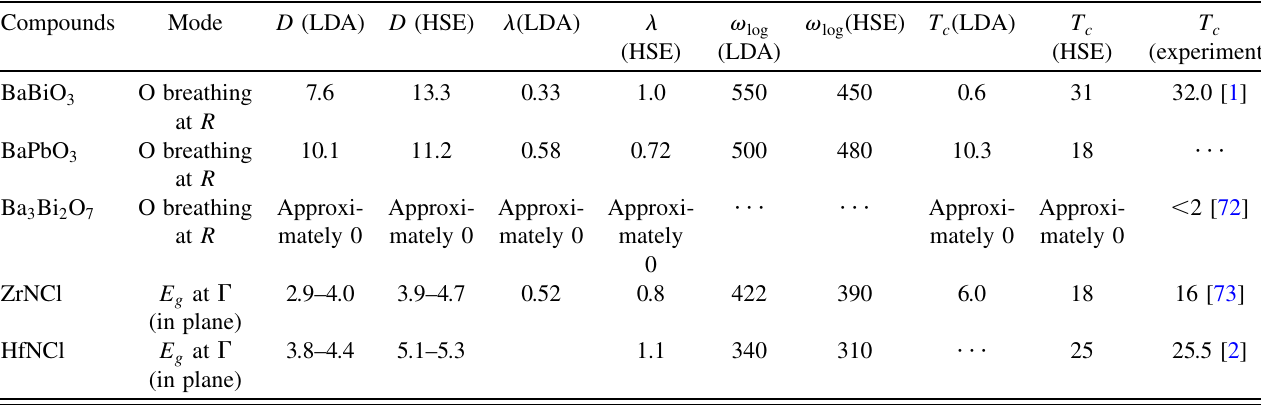
TABLE VI. The REPME D ( eV = (cid:3)A ) for the most important vibration mode, the total EPC (cid:4) , the average phonon frequency ! (K) in the LDA and the HSE06 are displayed with experimental T and the calculated T c in the HSE06 is estimated from the corresponding LRT LDA value, as is described in Sec. IV C. The critical hole doping. ! log temperatures in the LDA and the HSE06 are obtained from Eq. (9) using (cid:3) (cid:6) ¼ 0 : 10 . (We concentrate on the dominating effect of (cid:4) and ignore the small variations in the values of (cid:3) (cid:6) in the considered materials, which, in practice, affects the calculated T but does not affect our conclusions.) We approximate the LDA ! masses of Hf and Zr and their contributions to the total (cid:4) (about 40% , according to Ref. [14]).